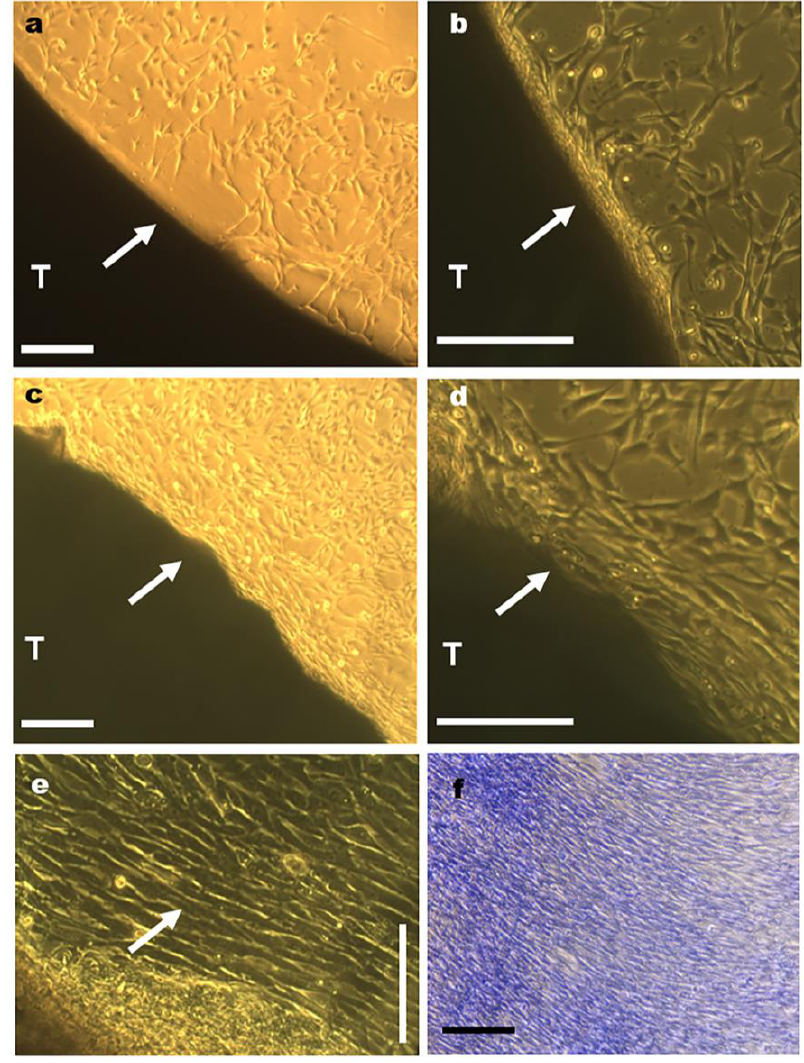
Figure 4. Tenocyte distributions in tendons (T) cultivated in vitro as observed with inverted light microscope. Images representative of the distribution of tenocytes that migrated from the lateral regions of tendons ( a – d , arrows) to the plastic substrate after a 6-day period of tendon cultivation ( a , b ) and that acquired a preferential orientation parallel to the long tendon axis 24 h later ( c – e ). Details of dense tenocyte distributions oriented parallel to the long axis of the tendon are indicated by an arrow ( e ). The number of the parallel aligned rows after a 12-day period of tendon cultivation increased even more as seen in a preparation stained with toluidine blue at pH 4.0 ( f ). Scale bars equal 250 µm ( a – d , f ) and 100 µm ( e ).